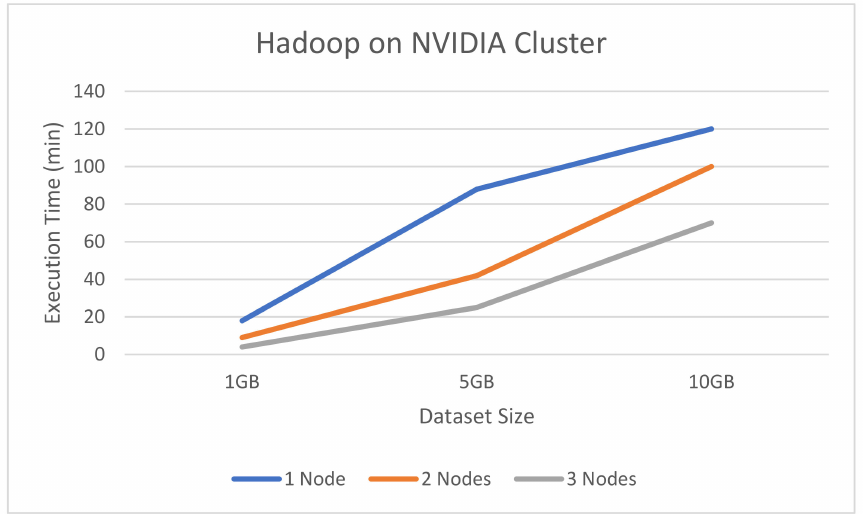
Figure 12. Execution time of Hadoop on the SBC